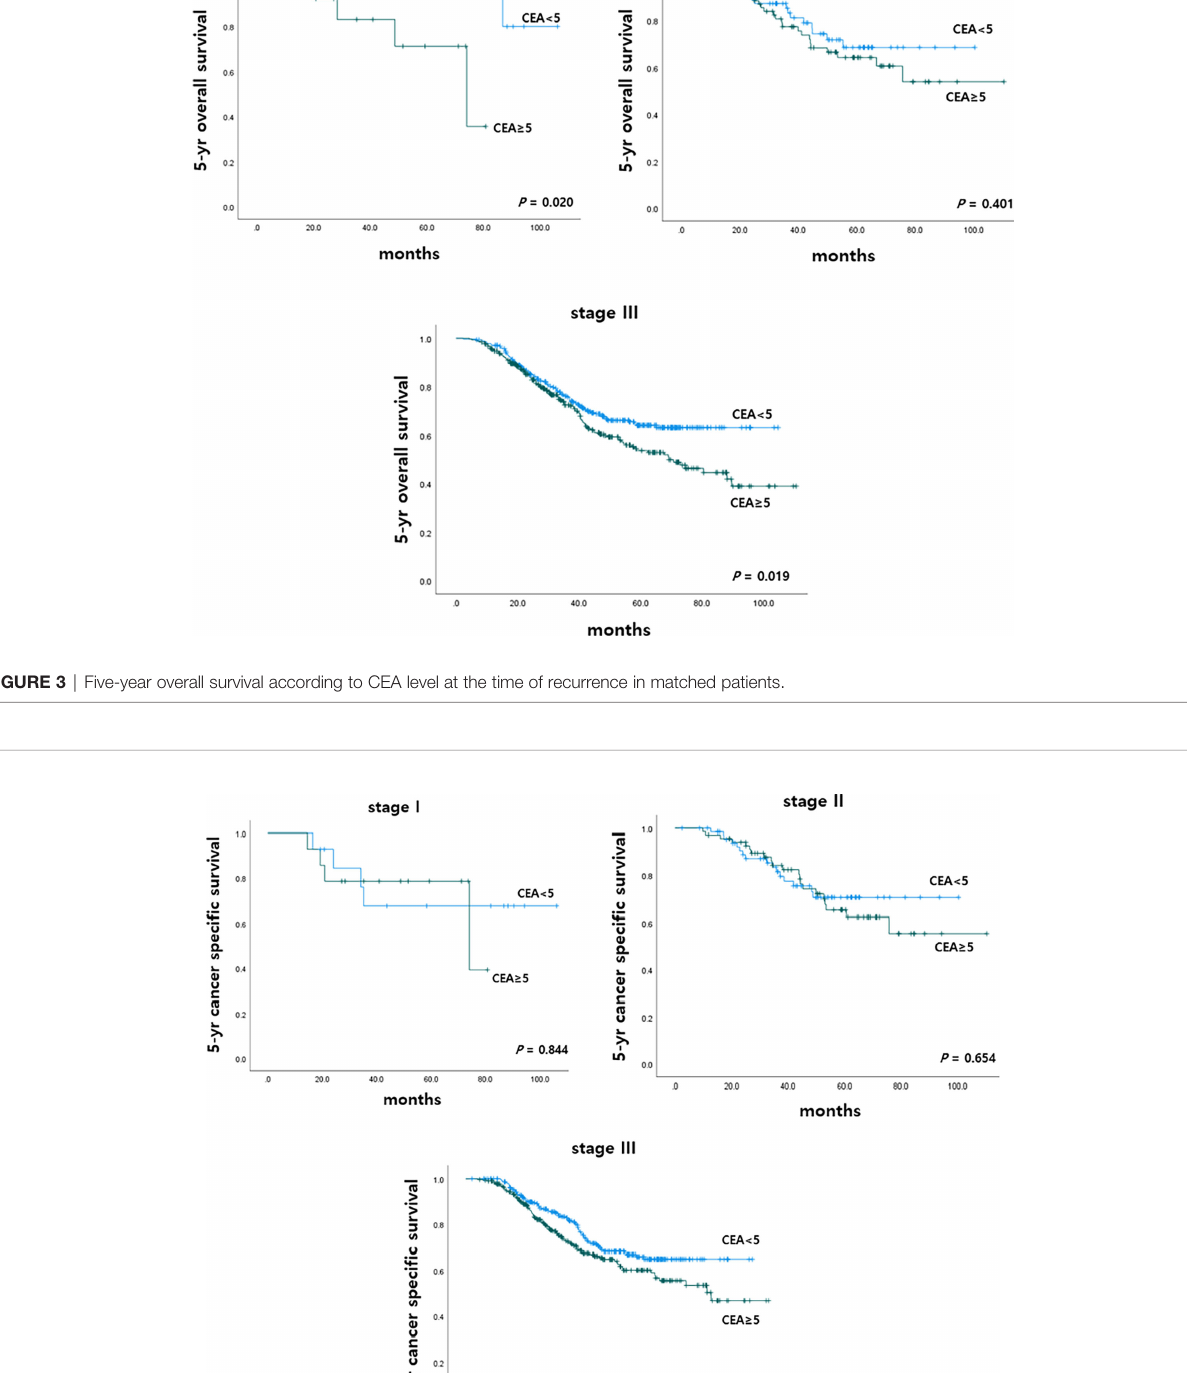
Frontiers in Oncology |